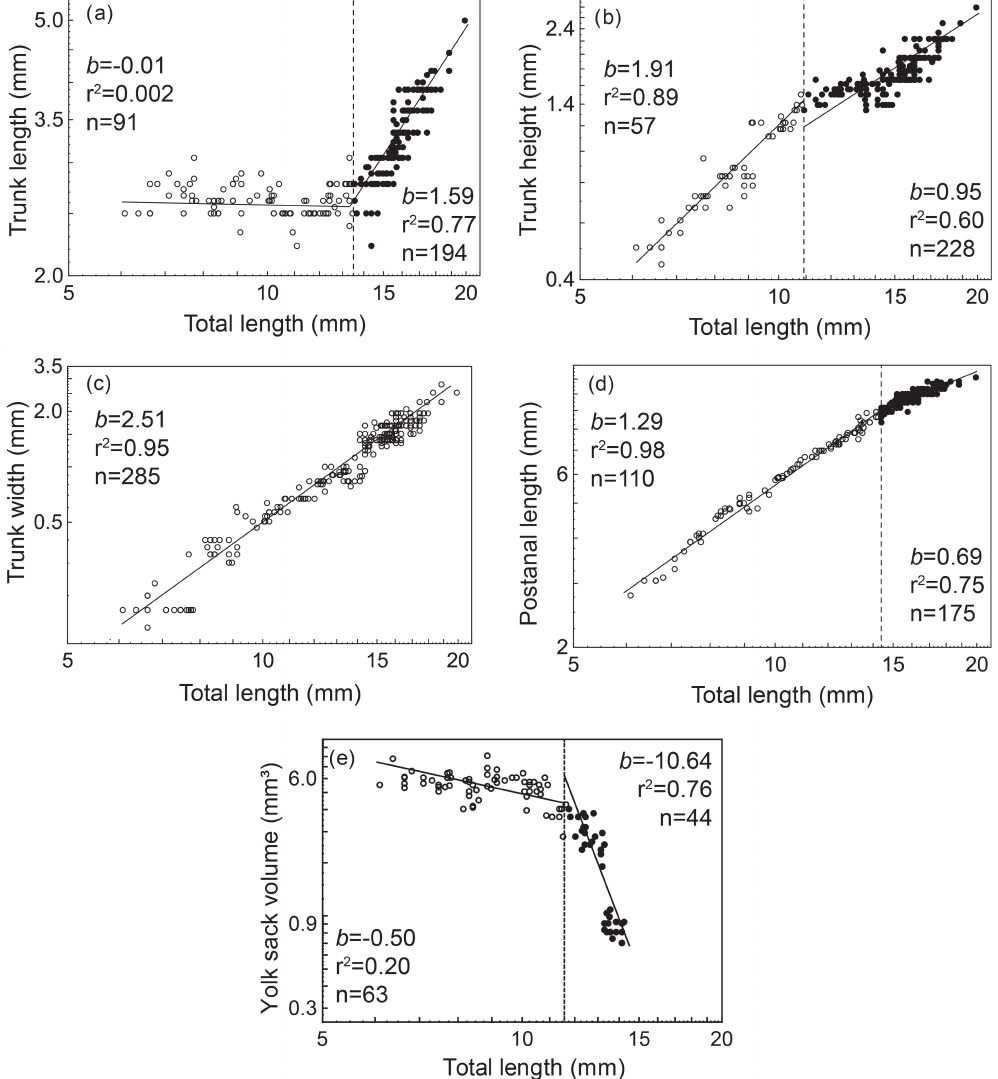
Fig. 4. Allometric growth of measurements on the trunk of Lophiosilurus alexandri during early development (0-29 days after hatching). The dotted line on total length represents the inflexion point of growth, b = allometric growth coefficient, r² = coefficient of determination, and n= number of individuals. (a) trunk length, (b) trunk height, (c) trunk width, (d) postanal length, (e) yolk sac